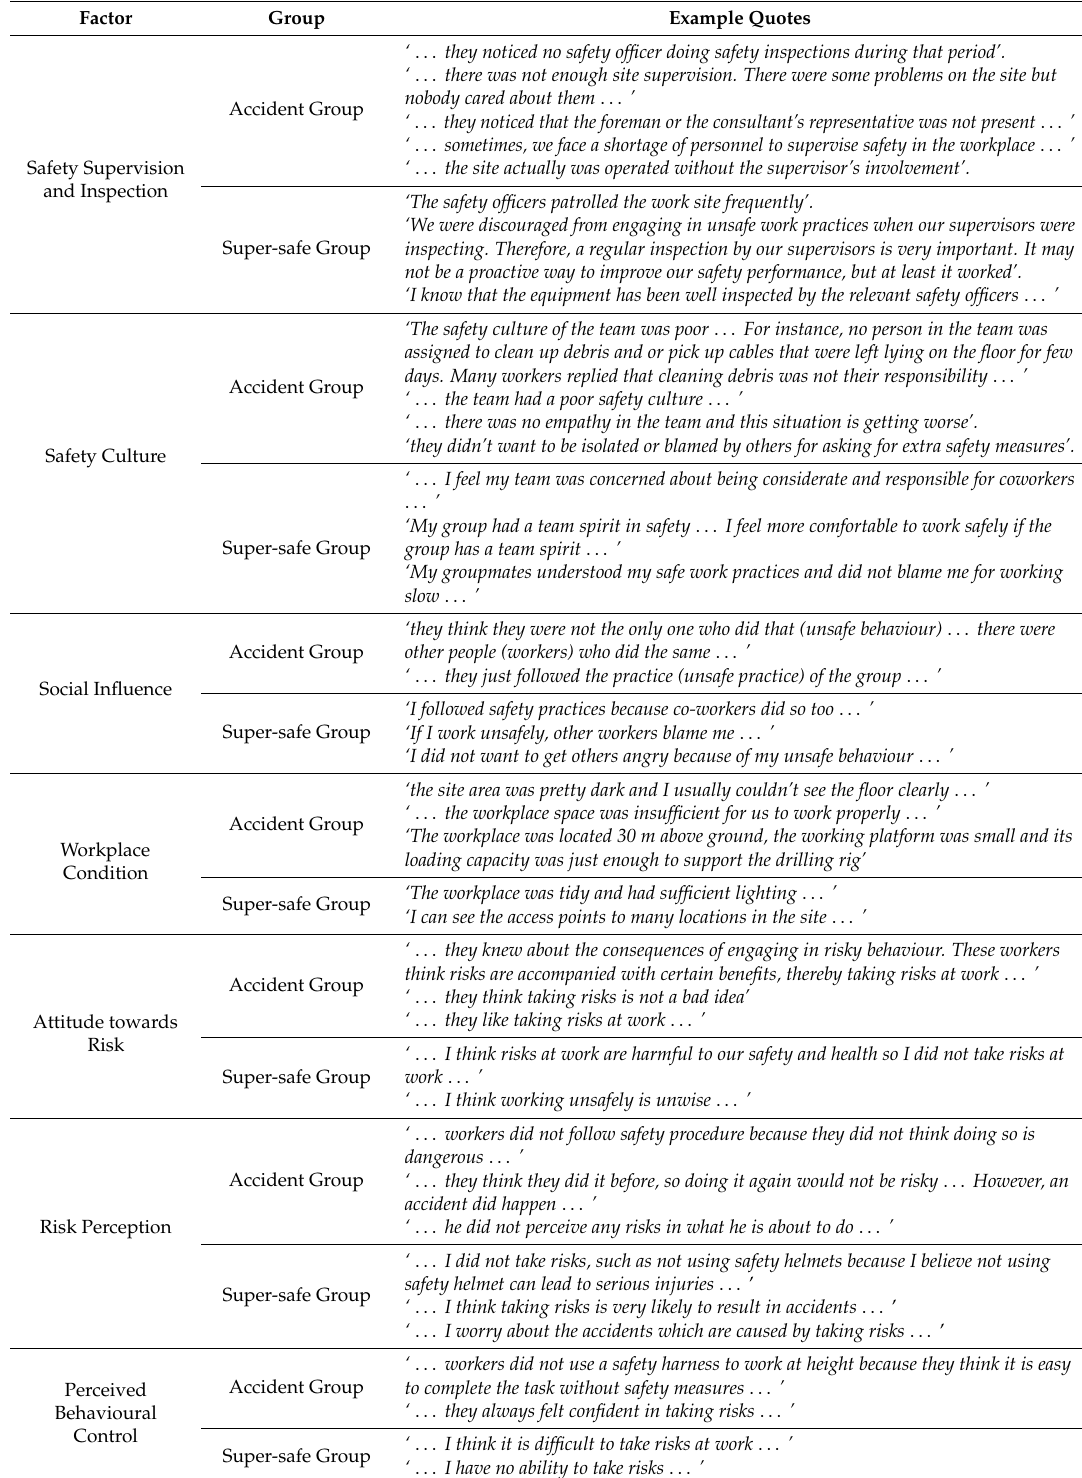
Table 3. A list of sample responses from the accident group and the super-safe